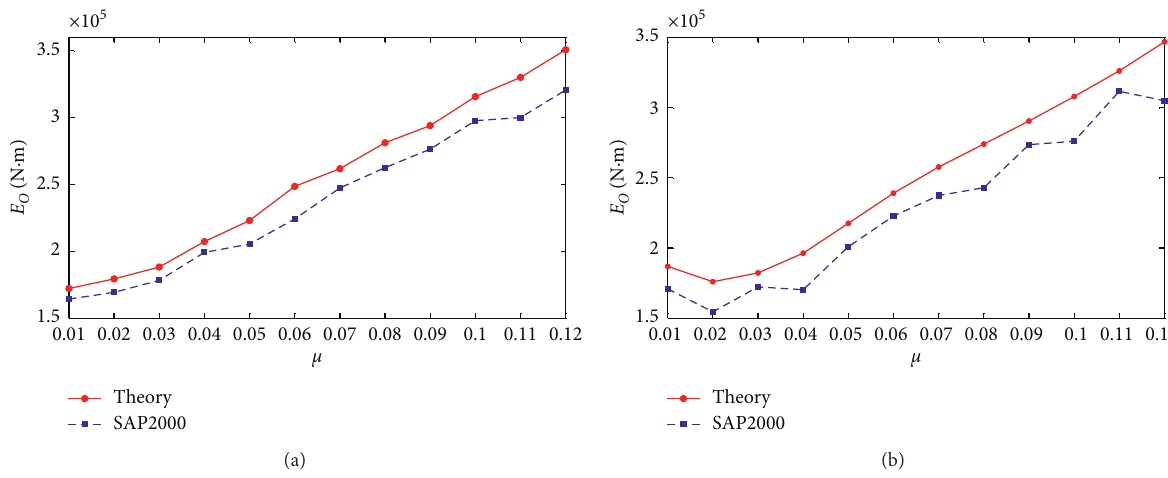
Figure 11: Comparison of seismic input energy between FE and analytical results. (a) T